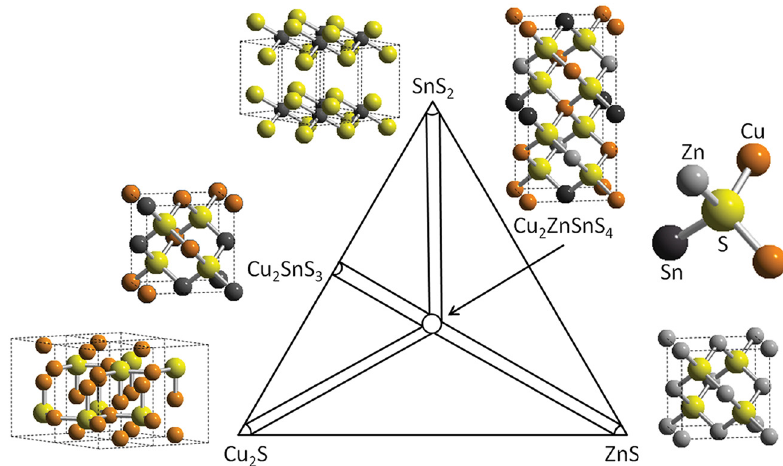
Figure 4: Schematic of a thin - fi lm Cu 2 S – ZnS – SnS 2 ternary phase diagram at a deposition temperature of 325°C. Reprinted with permission from ref. [ 54 ] . ©2011 AIP